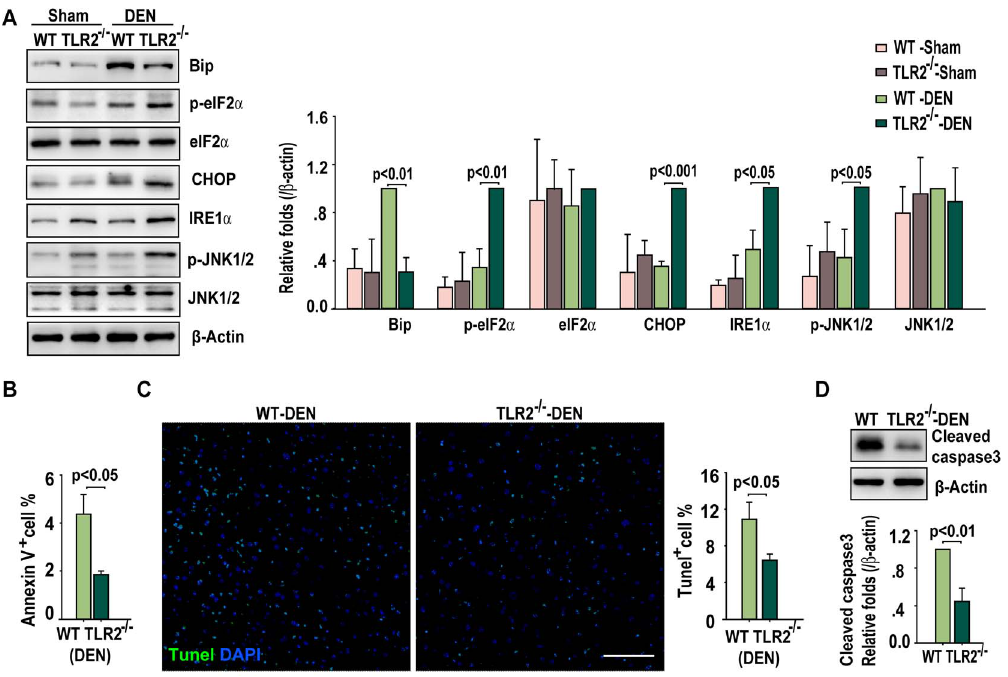
Figure 3. TLR2 deficiency enhances ER stress in DEN-injured liver tissues. (A) Western blot detection of Bip, phospho-eIF2 a , eIF2 a , CHOP, IRE1 a , phospho-JNK1/2 and JNK1/2 in livers of WT and TLR2 2 / 2 mice at one month post sham or DEN treatment. Data are presented as mean 6 SD (n=4 per group, right panel). (B) Apoptosis quantified by Annexin V staining is presented as mean 6 SD (n=4 per group). (C) Representative images of TUNEL staining (green) with liver sections from WT and TLR2 2 / 2 mice at one month post DEN treatment. The cell nuclei were counterstained with DAPI (blue). Scale bar, 75 m m. Eight magnified (20 6 ) fields per liver were counted for the percentage of TUNEL-positive cells. Data are presented as mean 6 SD (n=4 per group, right panel). (D) Western blot detection of cleaved caspase-3 in livers of WT and TLR2 2 / 2 mice at one month post DEN treatment. Data are presented as mean 6 SD (n=4 per group, bottom panel).